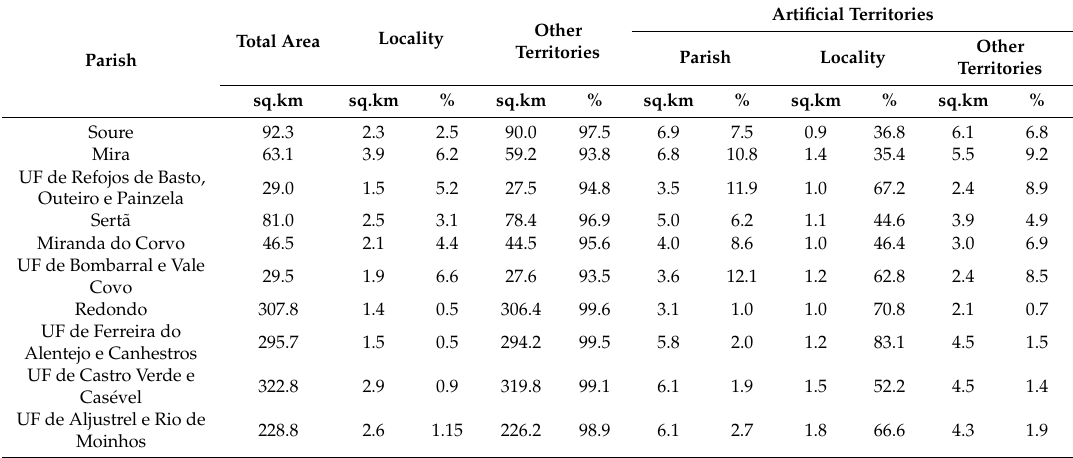
Table 4. Area and Artificial territories of APU (TIPAU) and Code 3 (DEGURBA) parishes, their localities (with the municipal headquarters), and other